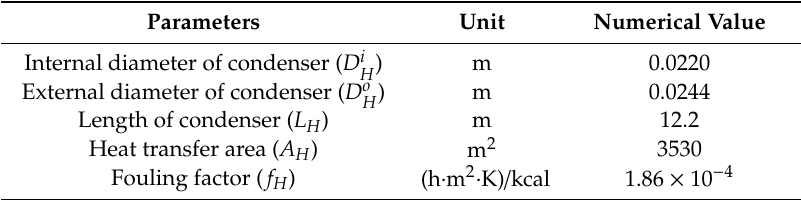
Table 1. Brine heater parameters of the MSF